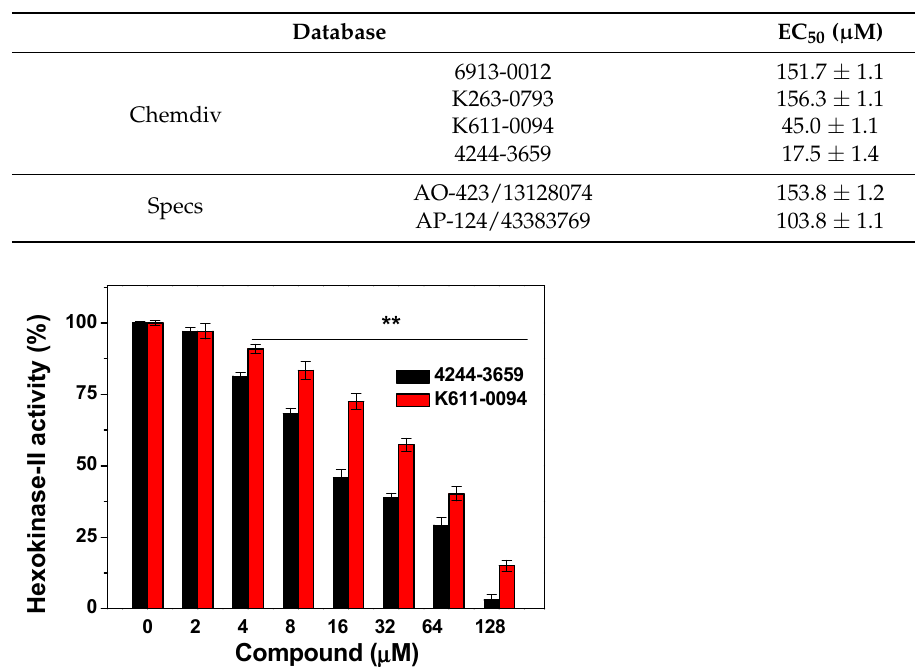
Figure 3. Inhibition of compounds 4244-3659 and K611-0094 on Hexokinase-II activity. After Hexo- kinase-II enzyme was incubated with various concentrations (from 1 to 128 μ M) of compound, Hexokinase-II activity was tested via a Hexokinase-II inhibitor screening kit. All data were ex- pressed as mean ± SE from three independent experiments. ** p < 0.01 vs. the control